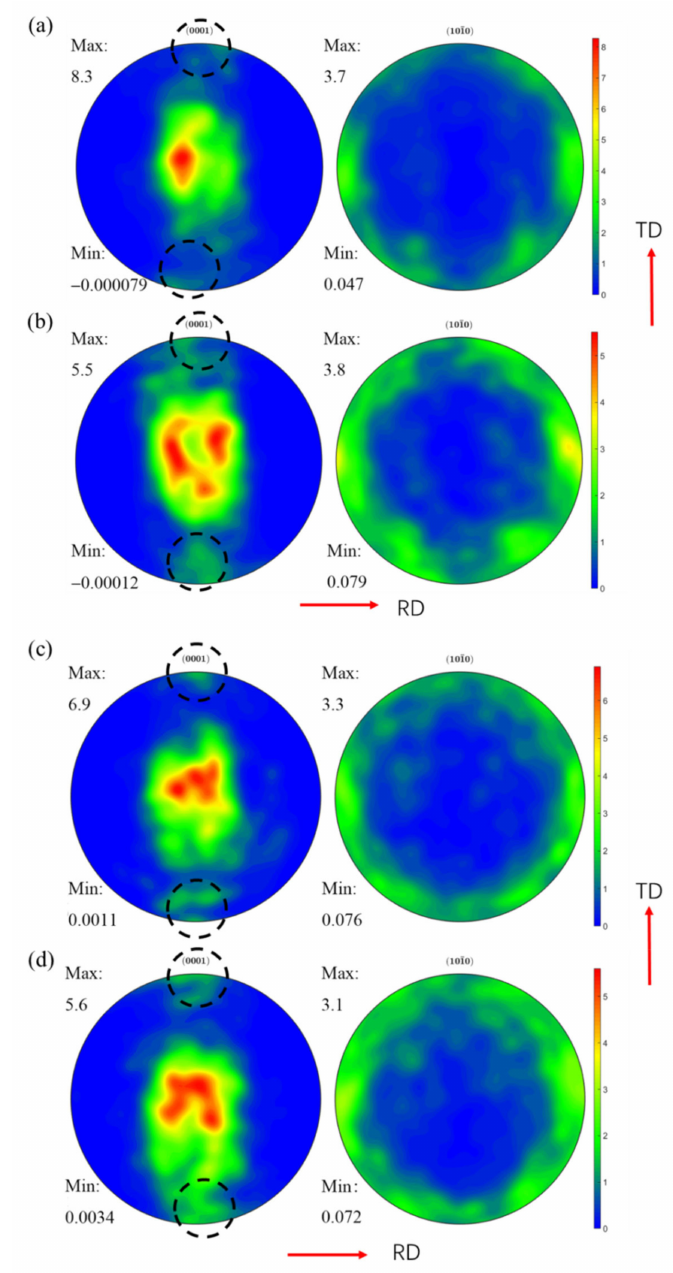
Figure 7. Pole figures of samples that loaded at ( a ) 0.001 s − 1 and 293 K, ( b ) 1300 s − 1 and 293 K, ( c ) 1300 s − 1 and 213 K, and ( d ) 1300 s − 1 and 488